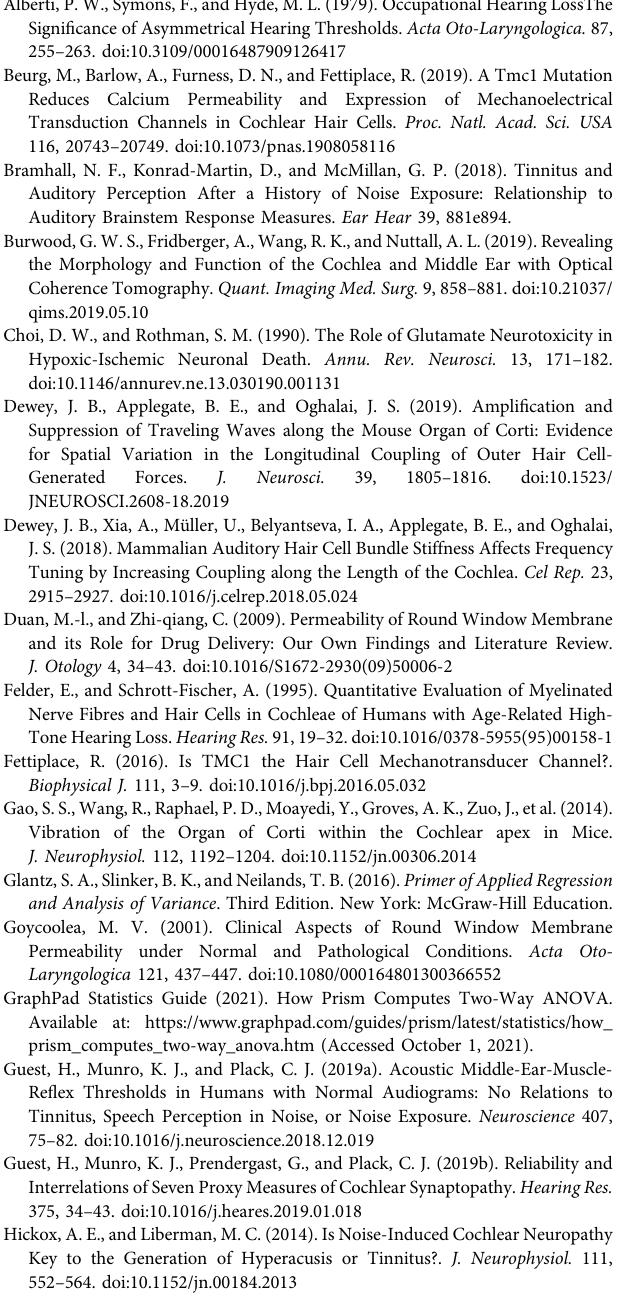
Supplementary Figure S2 | Automatic method for detecting, mapping, and counting ribbons and postsynaptic densities (PSDs). (A) Image of inner hair cells (IHCs) with CtBP2-labeled ribbons shown in green and Homer-labeled PSDs in red. Magni fi ed image of a co-localized ribbon and PSD is shown in the bottom left